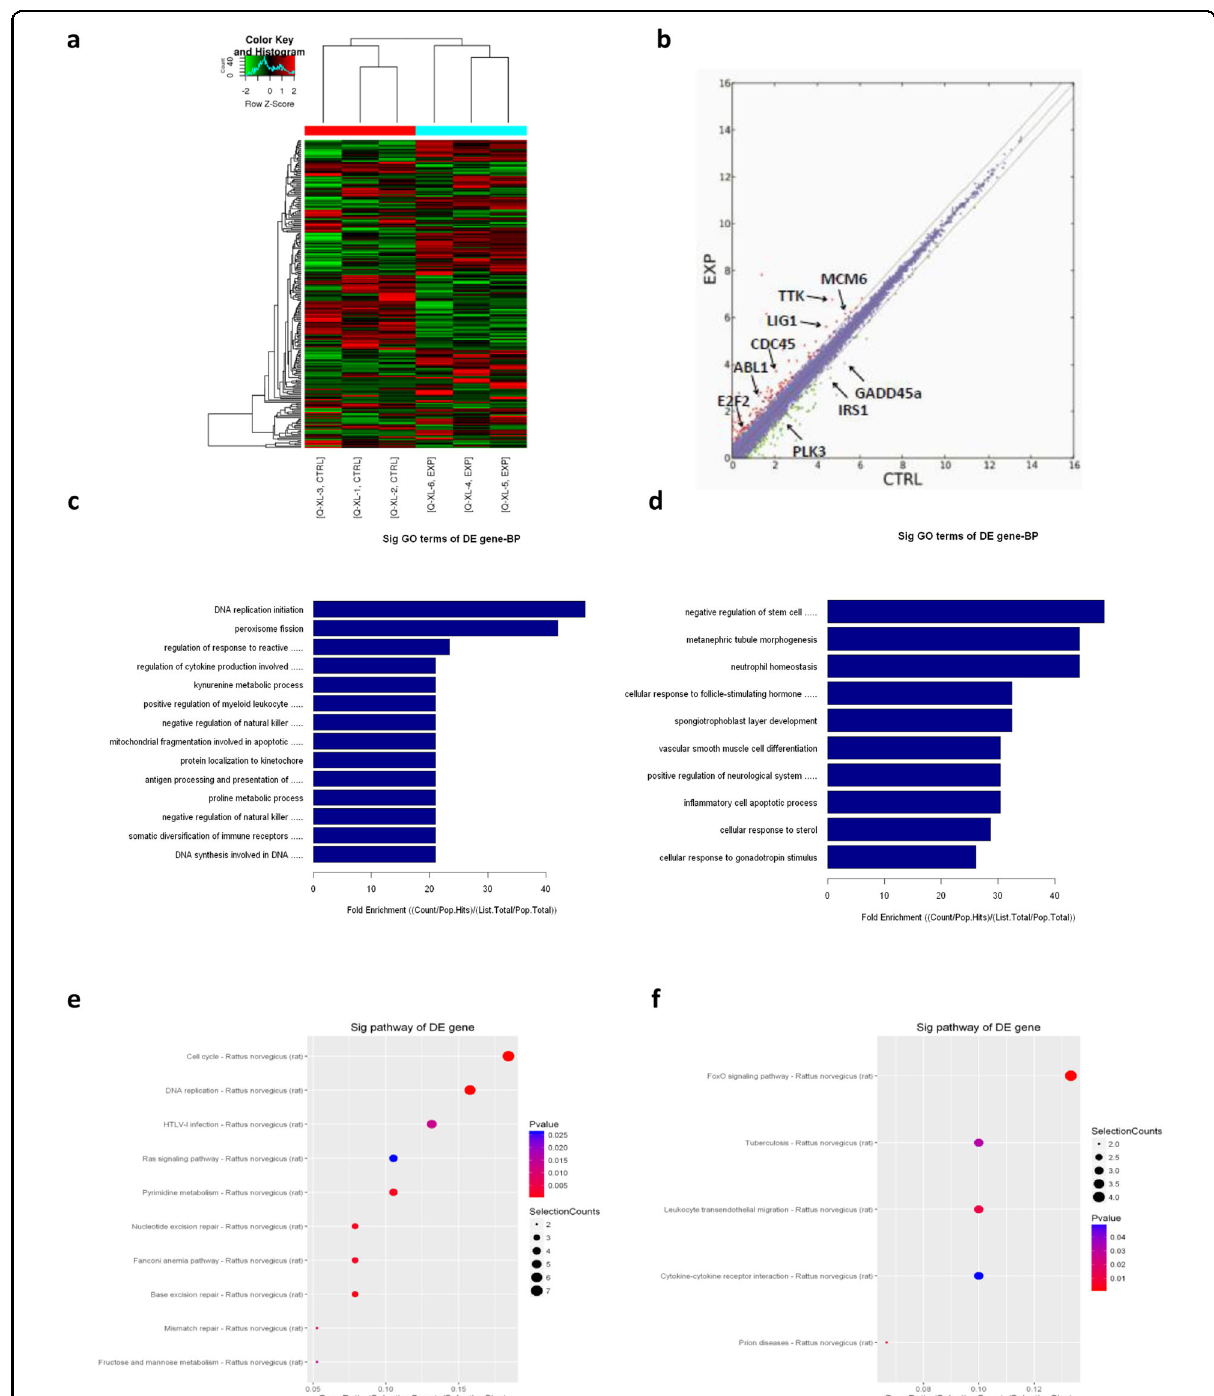
Fig. 5 Microarray analysis of glutamate-treated cells. a Raw data of microarray. b Analysis of differentially expressed genes in glutamate-treated cells compared to mock-treated cells. c , d Upregulated ( c ) or downregulated ( d ) biological processes in glutamate-treated cells compared to mock- treated cells. e , f Upregulated ( e ) or downregulated ( f ) signaling pathways in glutamate-treated cells compared to mock-treated